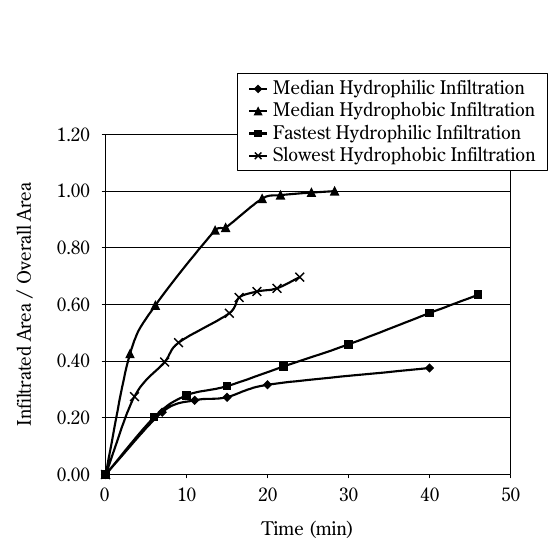
Fig. 4a Extent of infiltration as a function of time for the hy- drophilic agglomerates. The diameter d of each agglom- erate is indicated in the legend.